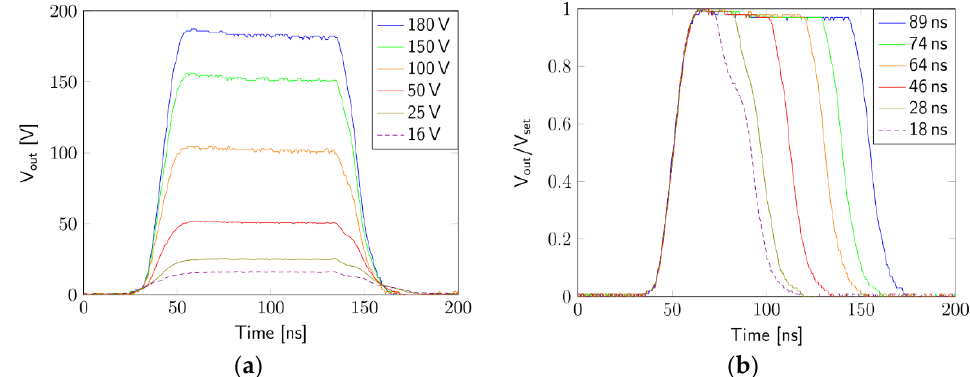
Figure 3. Measurement of the output signal: ( a ) different voltages with a set pulse length of 89 ns; ( b )